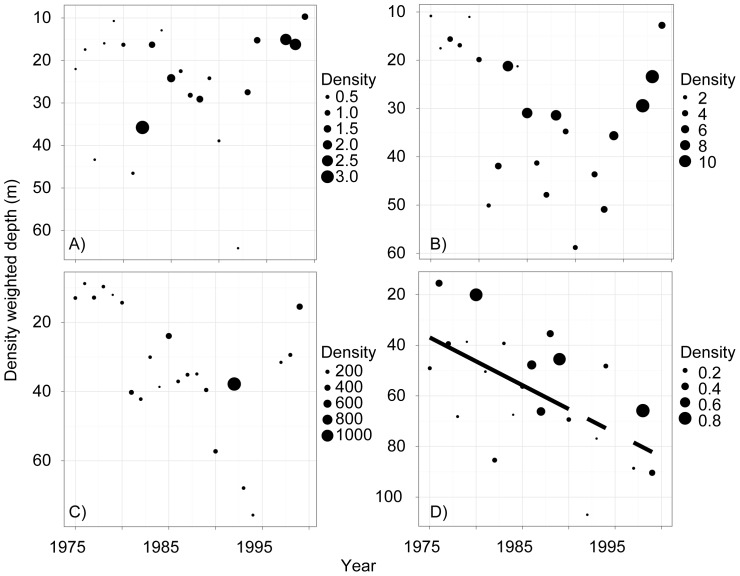
Abundance and density-weighted average summer depth of phytoplankton groups.Panels: A = Chrysophytes; B = Cryptophytes; C = Cyanobacteria; D = Diatoms. Cyanobacteria does not include picoplankton, which can be important contributors to Lake Baikal primary productivity in the summer, but are not routinely measured. Bubble size indicates average abundance (1000 cells l−1).